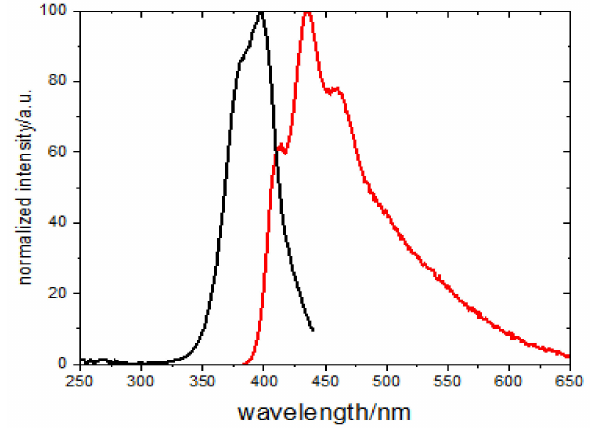
Figure 3. Excitation ( λ em = 435 nm, black line) and emission ( λ ex = 370 nm, red line) spectra of Bpy-SH in powder